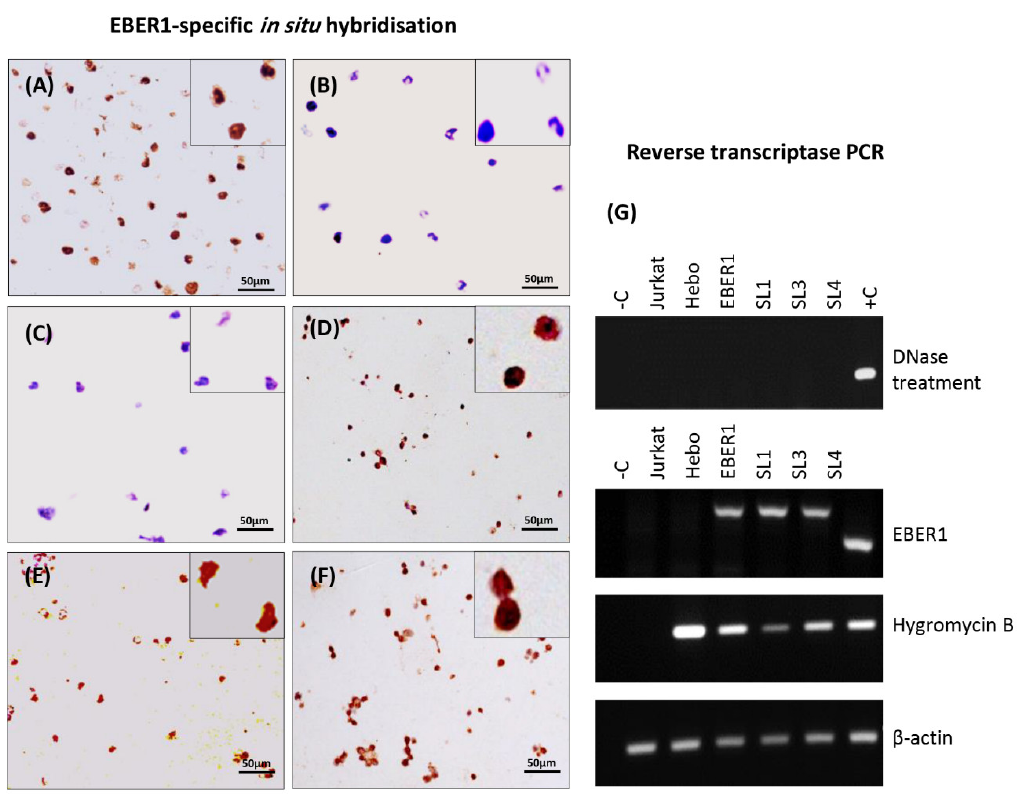
Figure 2. Confirmation of successful transfection . EBER1 expression in transfected cells was con- firmed by EBER1-specific in situ hybridisation. ( A ) Strong nuclear signal (brown) was observed in EBV-infected cell line, B95.8, used as a positive control. ( B ) Untransfected cells or ( C ) cells trans- fected with pHebo (plasmid without the EBER1 insert) were clearly negative for EBER1 expression (blue/purple). Cell transfected with ( D ) wildtype EBER1 or ( E ) with ∆SL1 or ( F ) ∆SL3 were also clearly positive for EBER1. ( G ) RT-PCR was used to independently confirm the uptake of the plasmid. Total cellular RNA was isolated using the TRIzol method, and DNase treated to ensure no DNA contamination. A total of 5 µg of the DNase-treated sample was reverse transcribed to cDNA, and 50 ng was used for the RT-PCR to amplify EBER1 gene, Hygromycin B gene, and β–actin— housekeeping and loading control.